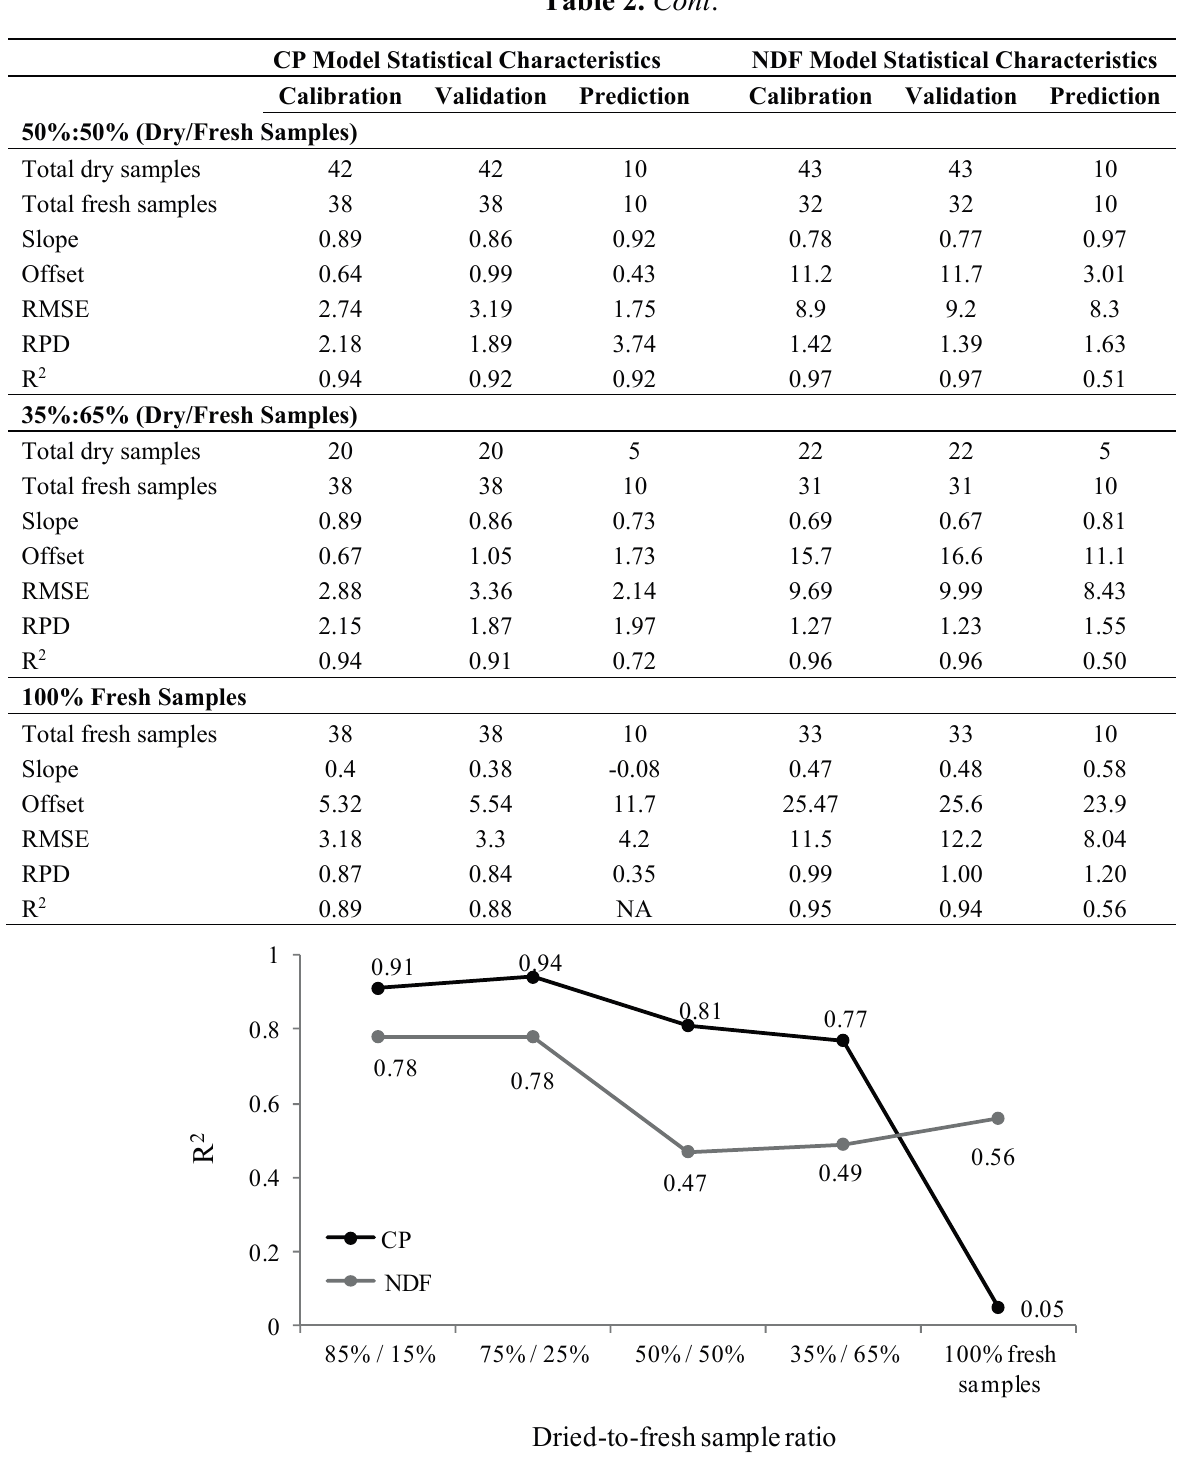
Figure 10. Regression between the reference and prediction for fresh samples only from the external dataset. R 2 decreases with number of dried